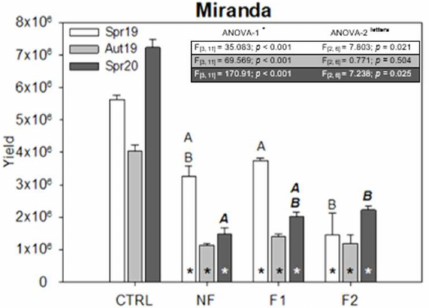
Figure 2. Results of Yield of R. subcapitata from the Miranda reservoir, when exposed to treatments: control (CTRL) and natural water treatments (NF—Non-filtered water; F1 and F2—filtered with 1.2 µ m and 0.22 µ m respectively). Data are stated as mean ± standard error (SE); n = 3. * Stands for significant differences detected by Dunnett test. Different letters (A, B for Spr19; and A , B for Spr20) stands for significant differences between treatments, detected by Tukey